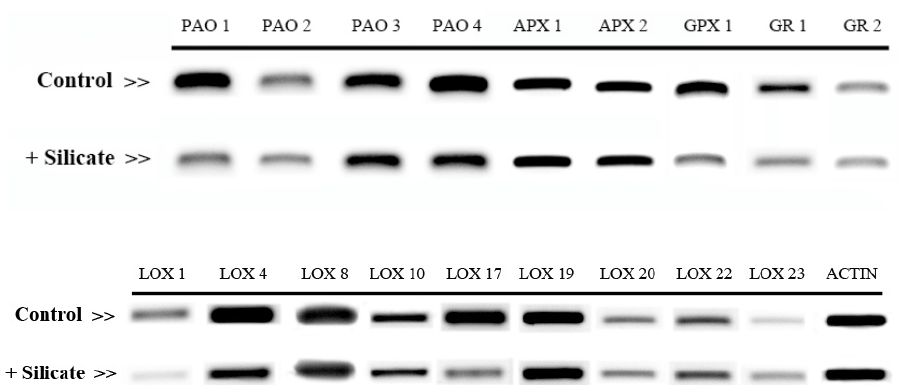
Figure 5. Semi quantitative RT-PCR results of selected genes affected by Si treatment from cucumber leaf samples in comparison with control plants.